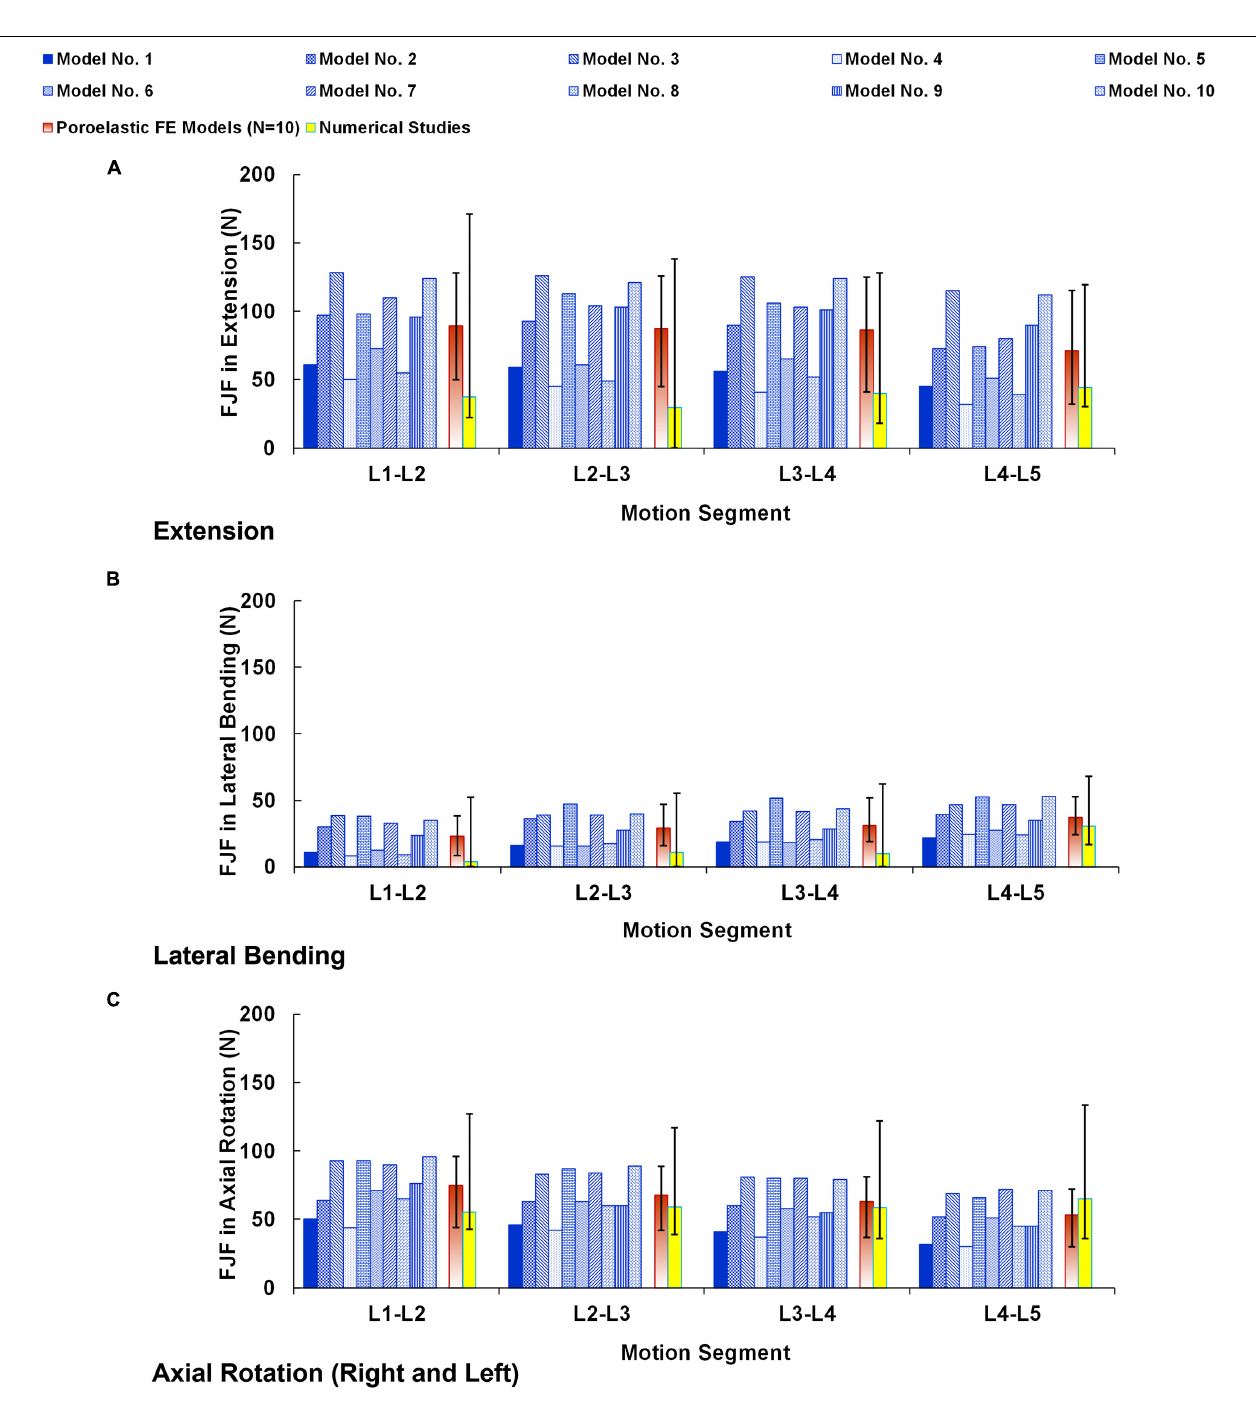
FIGURE 6 | Facet joint forces (FJF) for preoperative FE models compared with the numerical studies (Dreischarf et al., 2014) in (A) extension, (B) lateral bending, and (C) axial rotation. The reported FJFs in lateral bending and axial rotation are the average in the left and right directions. The error bars indicate the ranges of the